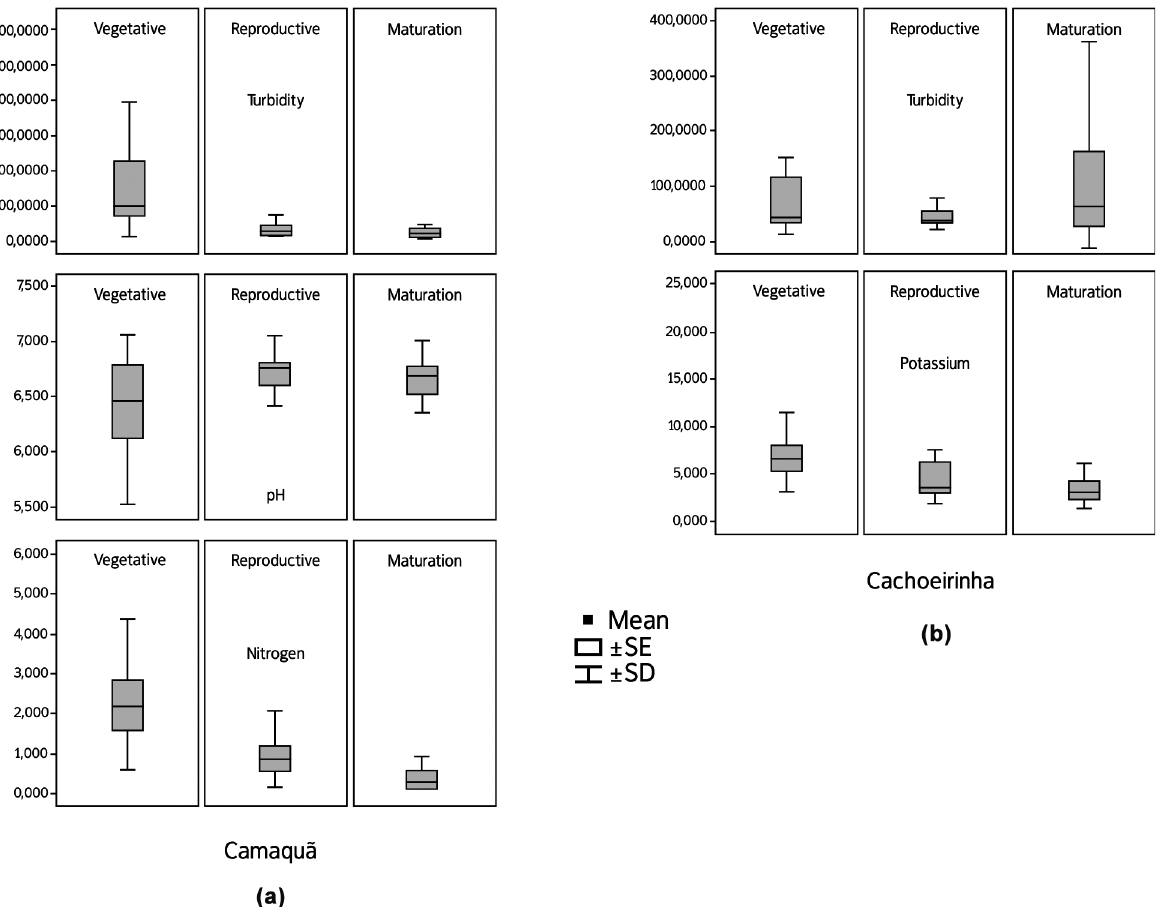
Figure 5 - Box-and-whisker plot representing the main discriminant variables between rice cultures phases. ( a ) Camaquã; ( b )